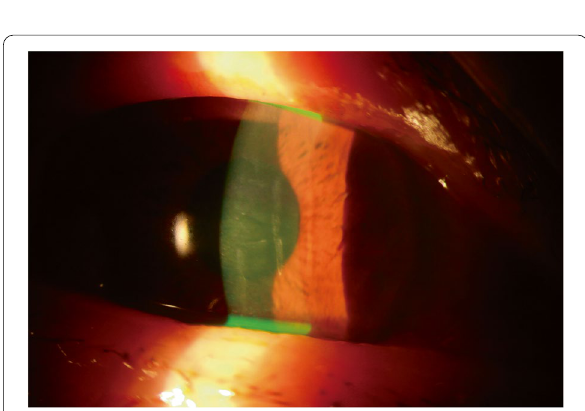
Fig. 2 Slit-lamp examination revealed severe corneal edema with Descemet membrane